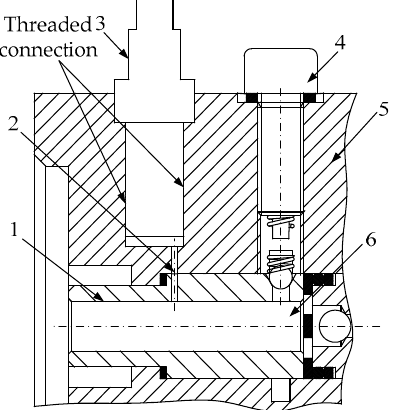
Figure 11. Schematic diagram of plunger auxiliary oil film pressure measurement. 1 — plunger sleeve; 2 — oil drain hole; 3 — pressure sensor; 4 — pressure valve screw; 5 — cylinder block; 6 — plunger cavity.